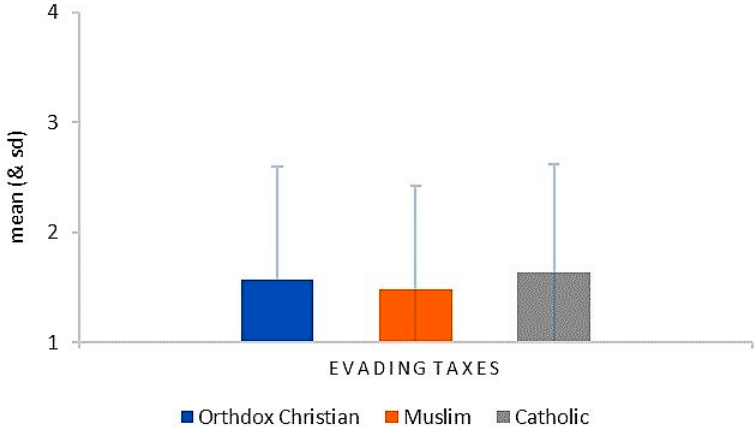
Figure 9. Evading taxes. (The error bars represent standard deviation).